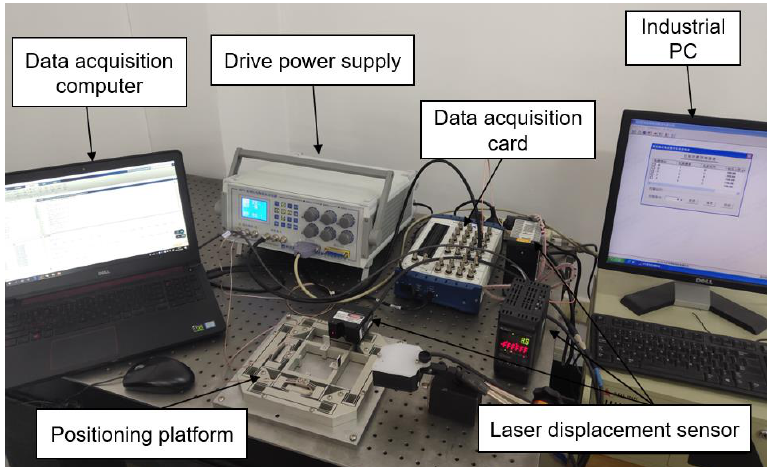
Figure 1. Experimental platform.